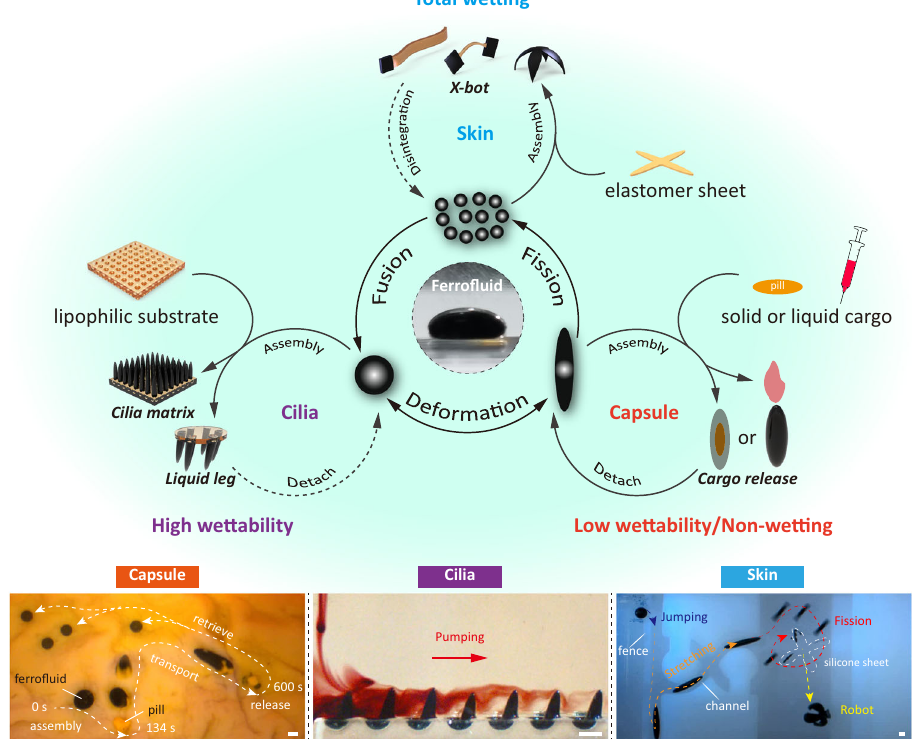
Fig. 1 | Multifunctionalityofwetting ferro fl uiddroplets. Schematic and experiment snapshots showing the versatility of ferro fl uiddroplets: serving asliquid capsules, serving as wireless liquid cilia, serving as wireless liquid skin. Scale bars, 2